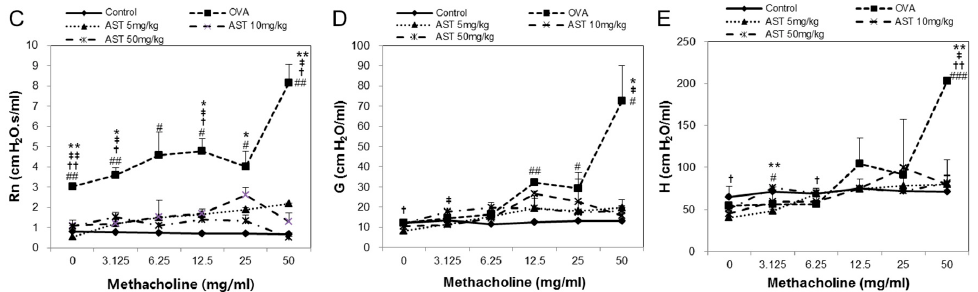
Figure 2. Assessment of allergen-induced airway hyperresponsiveness by the forced oscillation technique. The ( A ) Elastance (Ers); ( B ) Respiratory system resistance (Rrs); ( C ) Newtonian resistance (Rn); ( D ) tissue damping (G); and ( E ) tissue elastance (H) were determined by ovalbumin (OVA) or OVA + astaxanthin (AST). All data were expressed as means ± SD ( n = 2). # p < 0.05, ## p < 0.01, and ### p < 0.001 control vs. OVA. † p < 0.05 and †† p < 0.01 OVA vs. AST 5 mg/kg. ‡ p < 0.05 and ‡‡ p < 0.01 OVA vs. AST 10 mg/kg. * p < 0.05 and ** p < 0.01 OVA vs. AST 50 mg/kg.